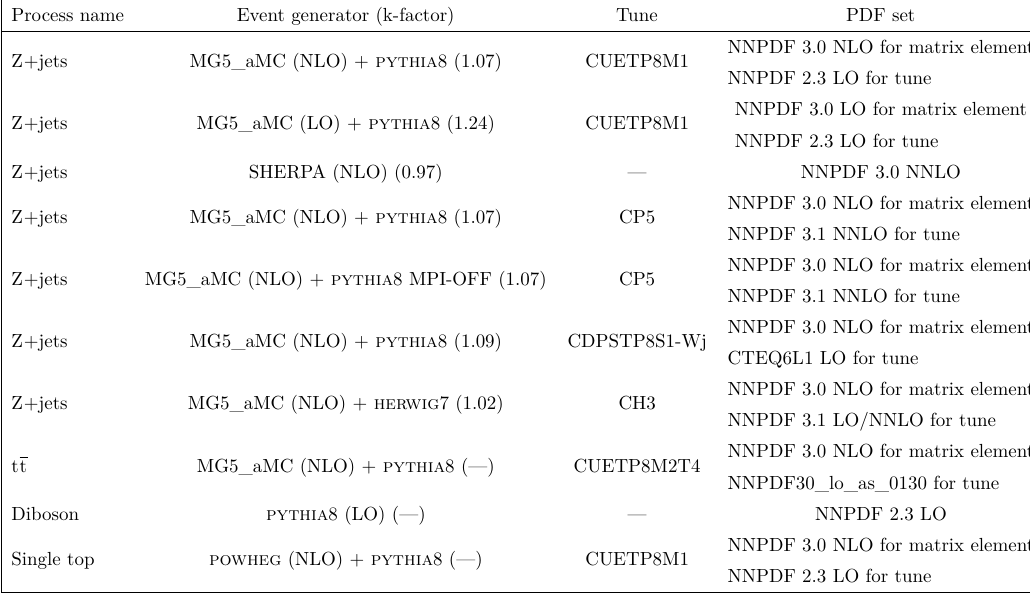
Table 1 . Summary of event generators with their k-factors (ratio of NNLO to NLO/LO cross section), PDF sets, and tunes used to produce both the signal and background event